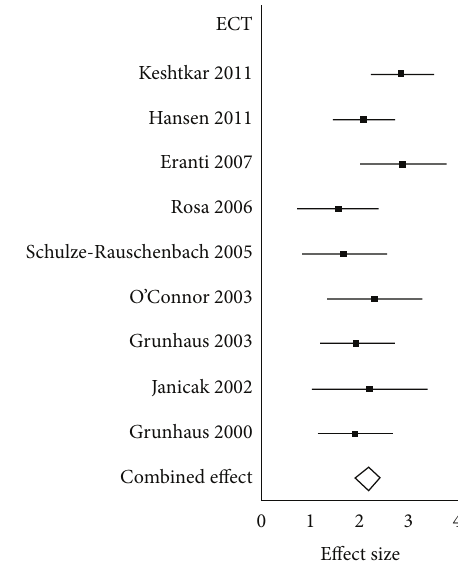
Figure 4: Forrest Plot